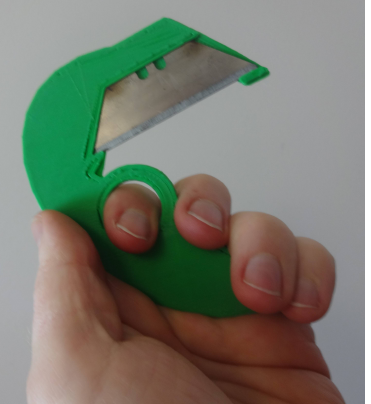
Figure 12. A dressing tool that mounts a replaceable utility blade on a 3-D printed handle with a guard.